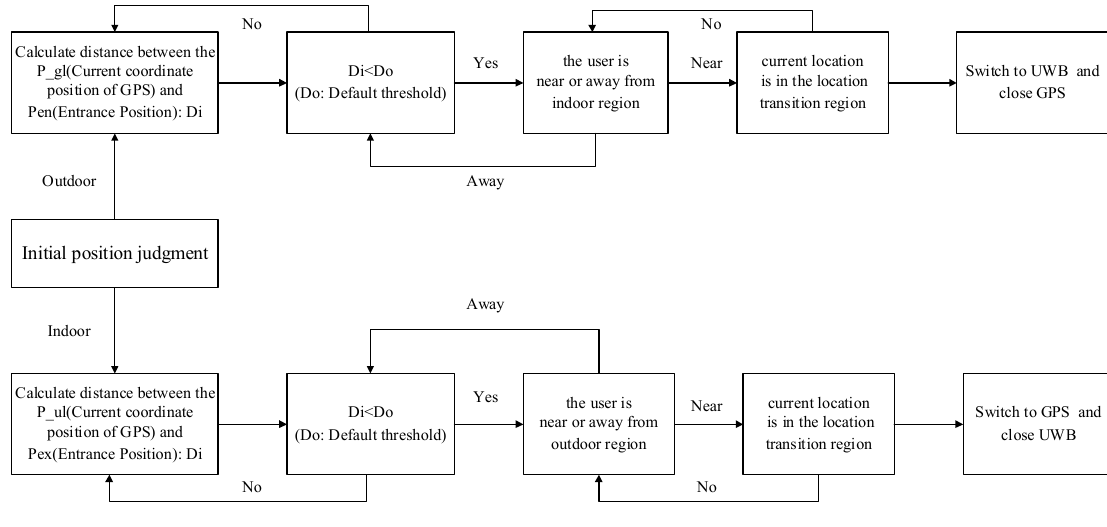
Figure 4. Positioning Switching algorithm.